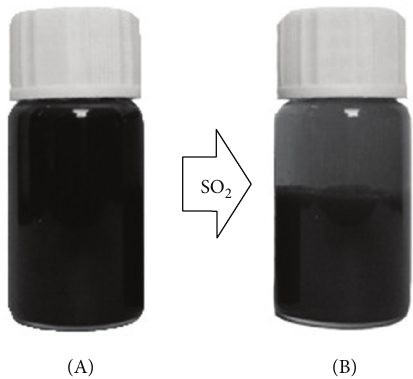
Figure 6: The photo of (A) SHA-Na solution; (B) desulfurization liquid after standing for 3 hours (SO 2 , 2500 ppm; gas flow, 0.12m 3 /h; absorption solution, 100mL; O 2 , 5vol%; 25 ∘ C).